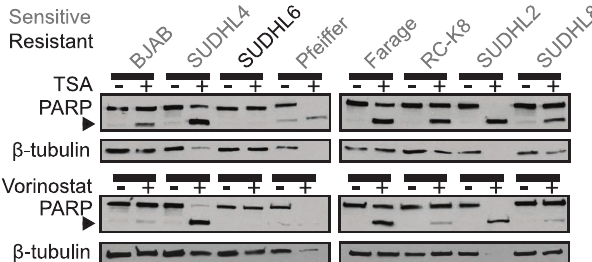
Figure 1. Trichostatin A and vorinostat induce PARP cleavage in a subset of DLBCL cell lines. The indicated DLBCL cell lines were treated with either 300 nM TSA (top panel) or 3 m M vorinostat (bottom panel) for 24 h and Western blotting was performed for PARP and b - tubulin (as a normalizing control). Note: in cases where cells undergo extensive PARP cleavage (e.g., SUDHL4, Pfeiffer, SUDHL2), tubulin can appear under-loaded (likely because tubulin also begins to be degraded in these dying cells). Cell lines used were GCB-like (BJAB, SUDHL4, SUDHL6, Pfeiffer, Farage, and SUDHL8) and ABC-like (RC-K8 and SUDHL2). Grey font indicates HDACi-sensitive cell lines; black font indicates HDACi-resistant cell line SUDHL6. The arrowhead indicates cleaved